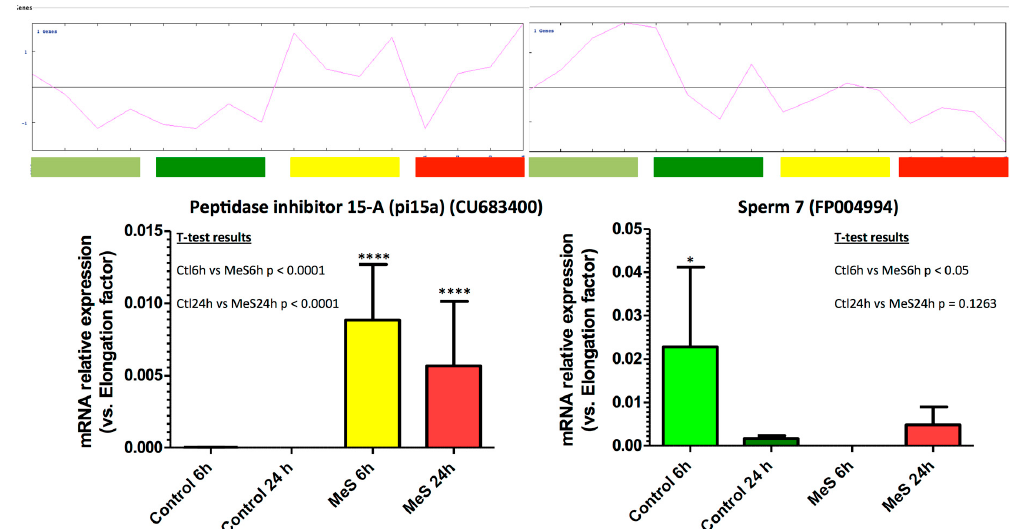
Figure 4. RT-qPCR measurements of mRNA expression of selected marker genes from the di ff erent clusters. Examples of cluster 1 (Peptidase inhibitor 15-a (pi15a) (CU683400), overexpressed in MeS treatment) and cluster 2 (Sperm7 (FP004994), underexpressed in MeS-treated 6hpf animals) are